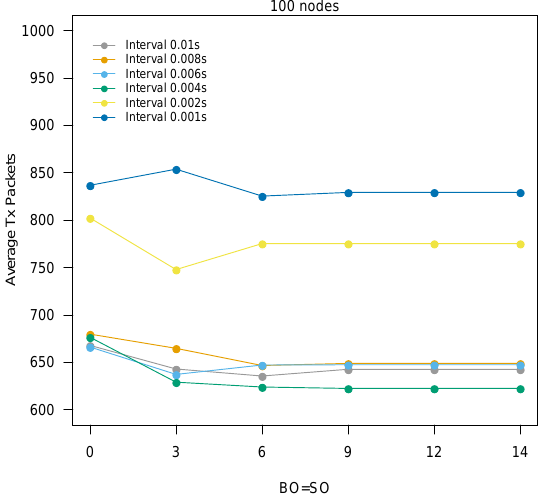
Figure 14. Network Tx packets overhead with different beacon